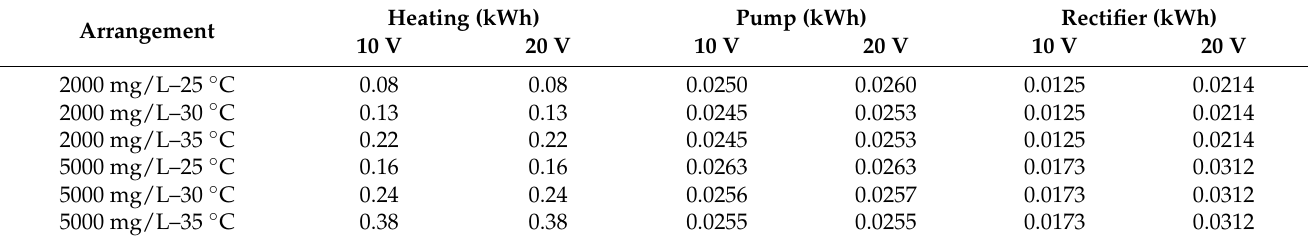
Table 9. Average energy demand of the pump and rectifier for each test.